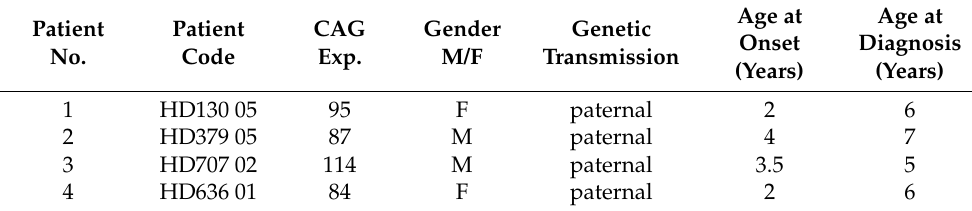
Table 1. Demographics.